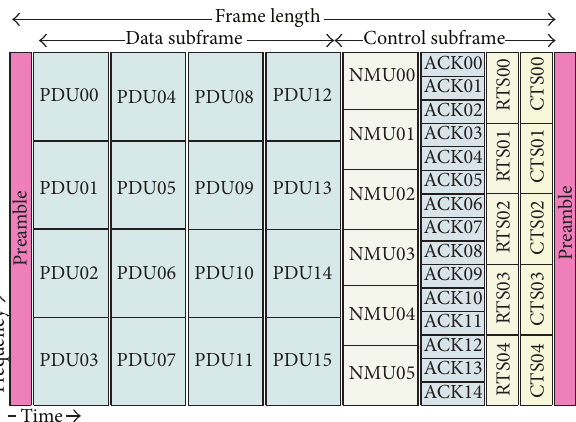
Figure 1: Example of frame structure ( 𝑁 = 16 PDU bins, 𝑀 = 6 NMUs, 𝐴 = 16 ACKs, and 𝐵 = 5 RTS-CTS